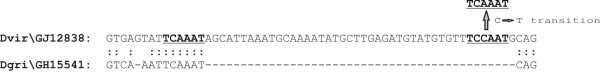
Genomic deletion of an intron by NHEJ. Alignment of intron 1 in Dvir\GJ12838 with unaligned nucleotides from the coding sequence of Dgri\GH15541, which experienced an intron loss at this position. Direct repeats (bolded and underlined) may have been used for microhomology directed ligation during NHEJ. The second cyostine in the downstream repeat may have undergone a C→T transition.